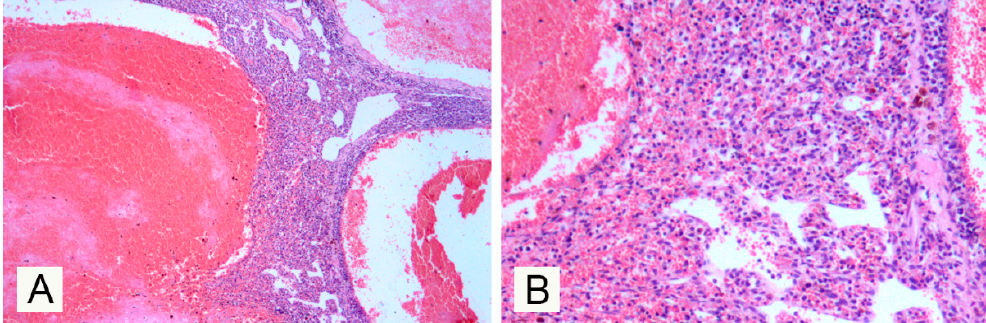
Figure 2. Histological photomicrograph of the splenic mass: ( A ) Cavernous pattern with large, regular and well-defined vascular spaces filled with erythrocytes (Haematoxylin-Eosin stain, Ob. 10×); ( B ) higher magnification, areas with a neoplastic capillary pattern (Haematoxylin-Eosin stain, Ob. 20×).